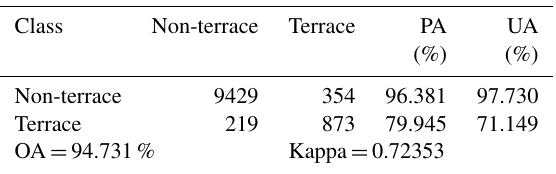
Table 3. Accuracy assessment of the 30m terrace map by the 10875 random test